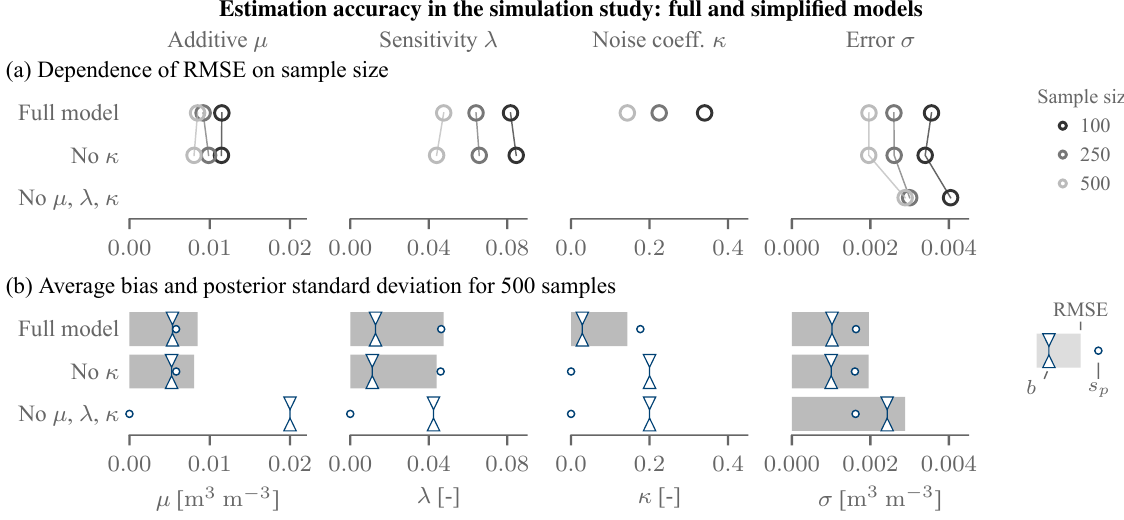
Figure 2. Simulation results illustrating the estimation fidelity. (a) Dependence on sample size. (b) Comparison of RMSE and the simulation bias magnitude b to the posterior standard deviation s p . In (a) and (b) the first line shows the full model, whereas κ is set to zero in the inference in the second, and λ , µ and κ were set to zero in the third. In these cases, the RMSE is equal to b , and these values are not shown in (a)